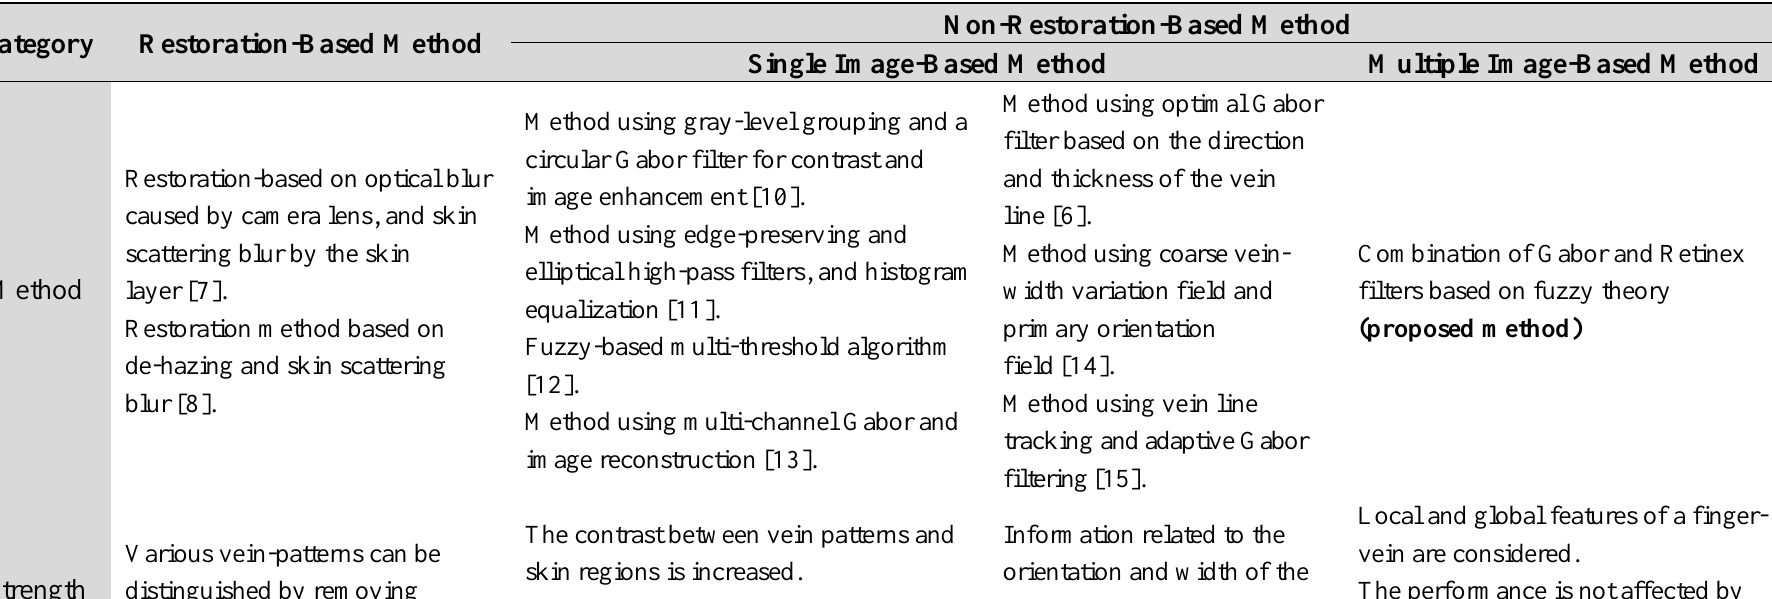
Table 1. Comparison of the proposed method and previous